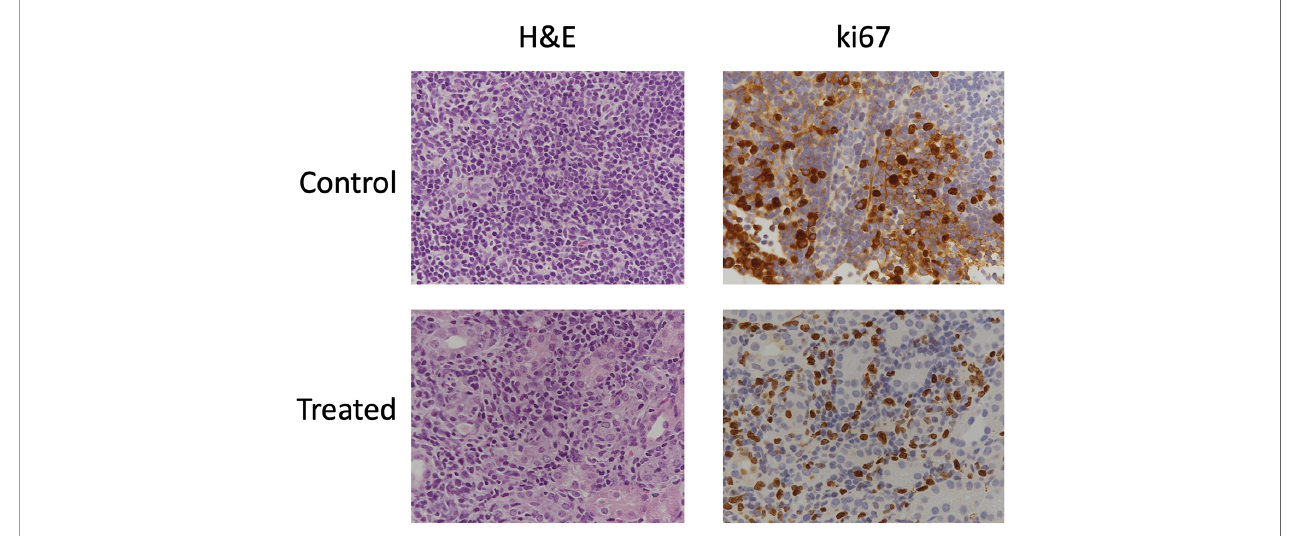
FIGURE 7 | Immunohistochemical stains of cellularity (H&E) and proliferation (Ki67) in solid lesions in control and treated